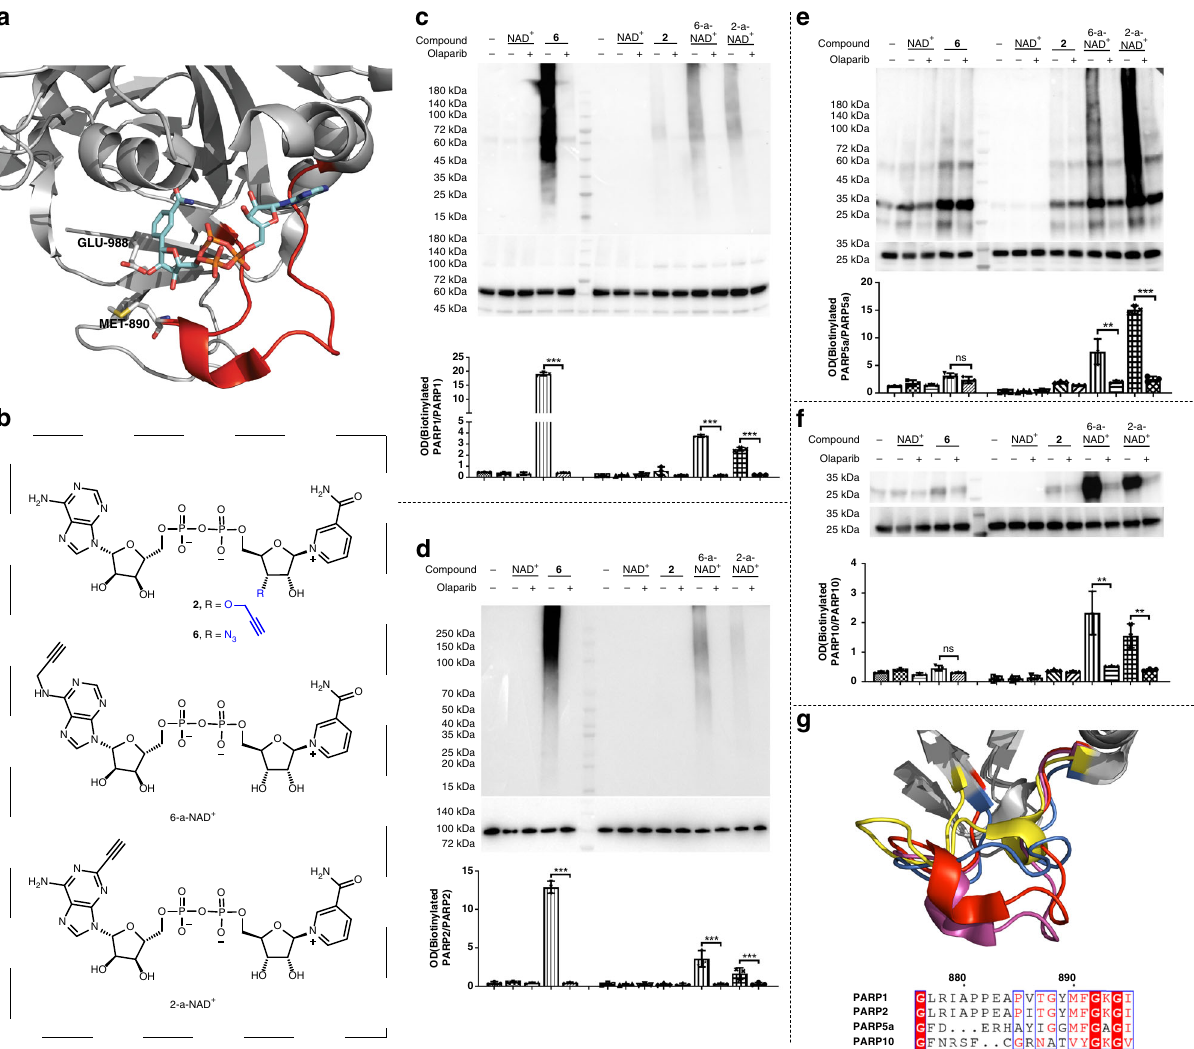
Fig. 5 Substrate activities of NAD + analogues for human PARPs. a X-ray structure of human PARP1 catalytic domain in complex with benzamide adenine dinucleotide (BAD) (PDB ID: 6BHV) 43 . Residues potentially interacting with 2 ′ - and 3 ′ -OH groups of the benzamide riboside are shown as sticks. The loop (G876-I895) at the active site of human PARP1 is shown in red. b Chemical structures of 2 , 6 , 6-a-NAD + , and 2-a-NAD + . c – f Substrate activities of 2 , 6 , 6- a-NAD + , and 2-a-NAD + for c human PARP1; d human PARP2; e catalytic domain of human PARP5a; and f catalytic domain of human PARP10. Automodi fi cations of PARP1, PARP2, PARP5a and PARP10 with NAD + analogues were carried out by incubating PARP enzymes with NAD + analogues in the absence and presence of 100 μ M olaparib at 30°C for 2 h. The reaction mixtures were then labeled with azido-biotin (for NAD + , 2 , 6-a-NAD + , and 2-a- NAD + ) or alkyne-biotin (for NAD + and 6 ) through click chemistry, followed by immunoblot analysis as detected by the streptavidin-HRP conjugate. PARP1, PARP2, PARP5a or PARP10 catalytic domain loading controls were detected by an anti-His 6 antibody or anti-PARP2 antibody. Automodi fi cation of PARP enzymes normalized to respective PARPs was analyzed by densitometry. ns: not signi fi cant, P > 0.05; ** P < 0.01; and *** P < 0.001 by one-tailed unpaired t -test. Error bars represent standard deviation of three replicates. g The loops at the catalytic sites of PARP1, PARP2, PARP5a and PARP10. Loops were overlaid based on the solved X-ray structures of PARP1 (red; PDB ID: 6BHV) 43 , PARP2 (magenta, PDB ID: 4ZZX) 44 , PARP5a (yellow; PDB ID: 3UH4) 45 and PARP10 (blue; PDB ID: 5LX6) 46 . Primary sequences were aligned for the loops at the catalytic sites of PARP1 (G876-I895), PARP2 (G442-I461), PARP5a (G1196-I1212) and PARP10 (G901-V918) 47 . Source data are provided as a Source Data fi